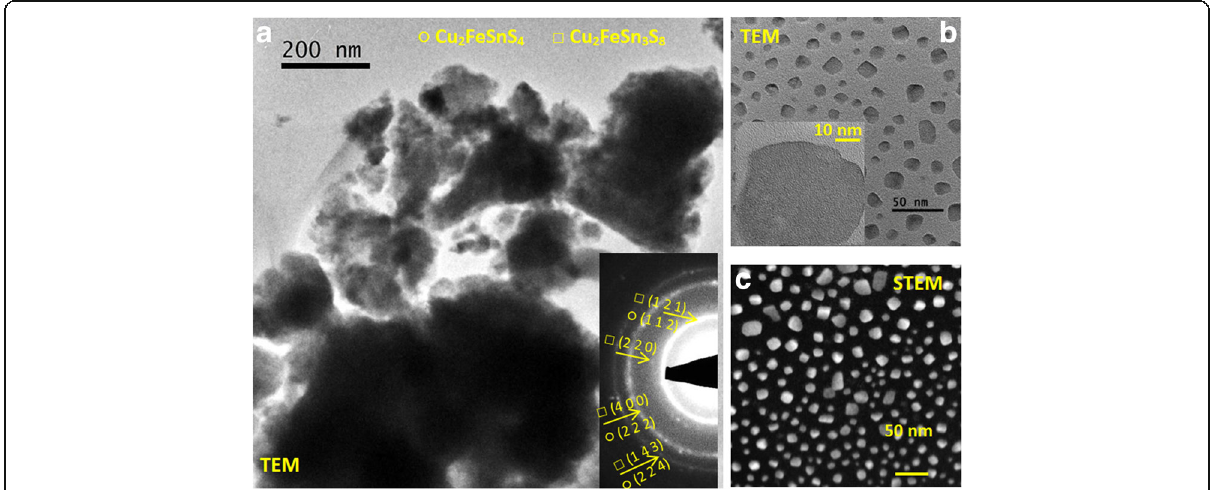
Fig. 7 TEM and STEM analysis of the CFTS sample. a TEM image of agglomerated particles and the corresponding ED in the inset . b TEM image of the isolated particles with a particle of about 40 nm in the inset . c STEM image of the isolated particles